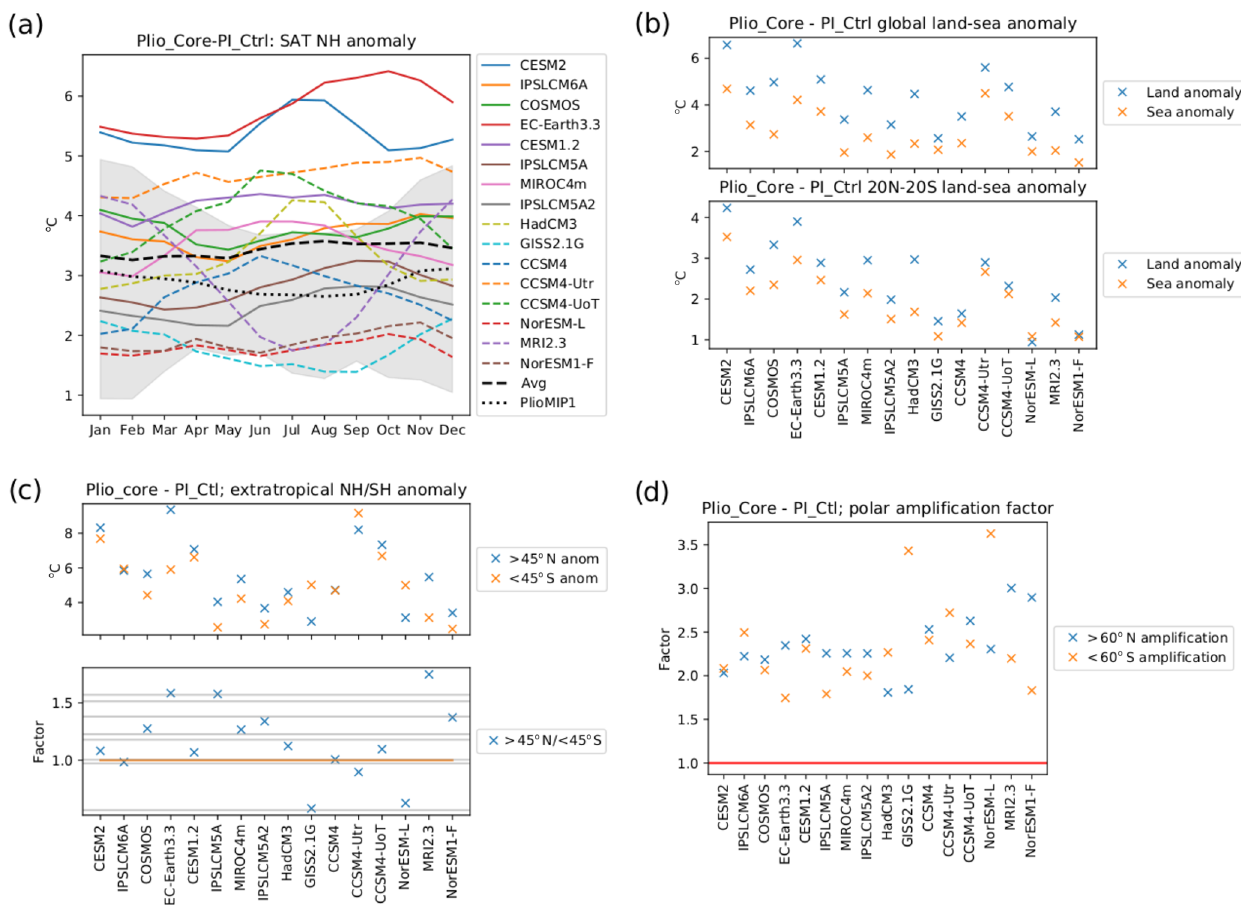
Figure 3. (a) Monthly mean NH Plio Core –PI Ctrl SAT anomaly for each PlioMIP2 model, with the PlioMIP2 multi-model mean shown by the dashed black line. The grey shaded region shows the range of values simulated by the PlioMIP1 models, and the PlioMIP1 multi-model mean is shown by the dotted black line. (b) SAT anomaly for land (blue) and sea (orange) from each model averaged over the globe (top panel) and the 20 ◦ N–20 ◦ S region (lower panel). (c) SAT anomaly for the northern extratropics (blue) and southern extratropics (orange) (top panel) and the ratio between them (lower panel). The horizontal grey lines on the lower panel show the values from individual PlioMIP1 models. (d) SAT anomaly poleward of 60 ◦ divided by the globally averaged SAT anomaly for the NH (blue) and the SH (orange). The red line highlights a ratio of 1 (i.e. no polar